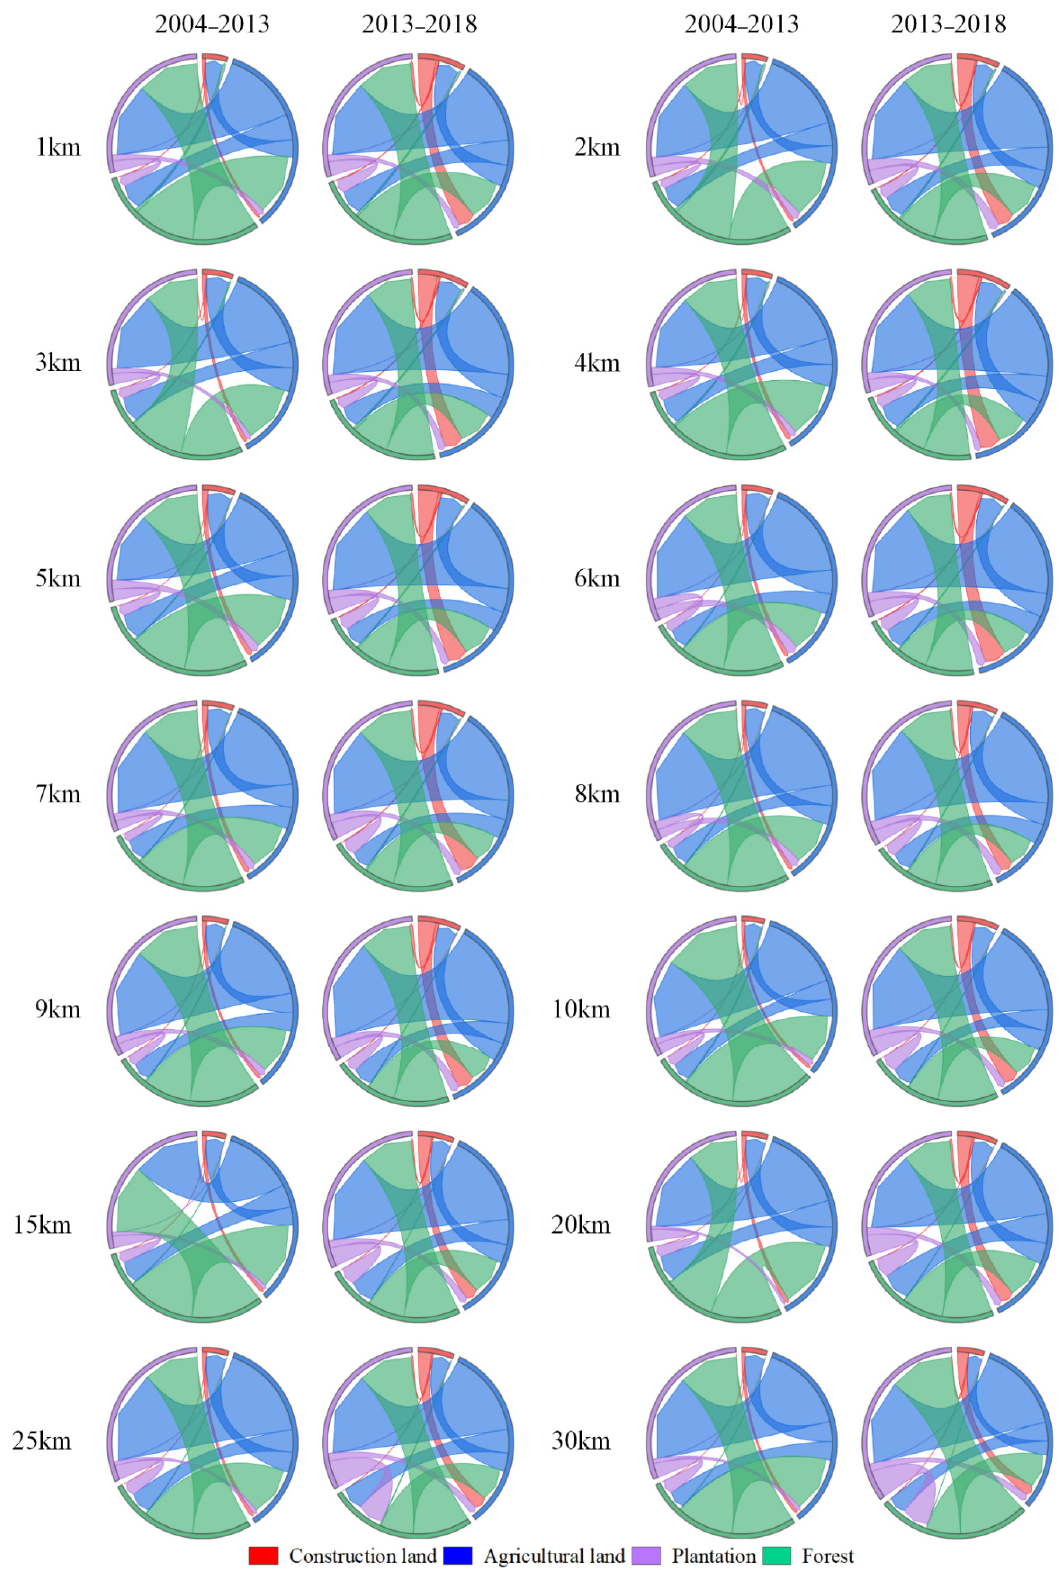
Figure 4. Land use transfer in the buffers of Kunming–Bangkok Highway in 2004–2013 and 2013–2018 (the arrow indicates the direction of transfer, and the width indicates the amount of transfer).